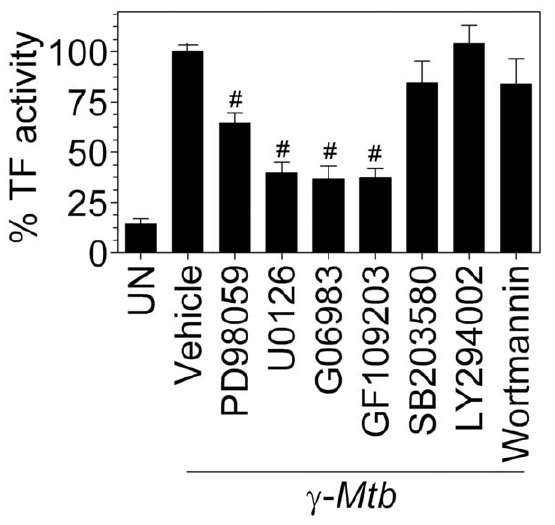
Figure 8. ERK and PKC pathways play a role in Mtb -induction of TF procoagulant activity. MDMs were pretreated with the MEK inhibitors, PD98059 and U0126 and PKC inhibitors, GF109203 and Go ¨ 6983, p38 MAPK inhibitor, SB203580 and PI3-AKT inhibitors, LY294002 and wortmannin (all used at 10 m M concentration) for 1 h. Cells were then stimulated with c - Mtb (10 m g/ml) for 9 h. Cell surface TF activity measured in factor X activation assay. Values obtained for c - Mtb alone treated cells are represented as 100%. # indicates significant inhibition compared to c - Mtb alone treated cells (P=0.0001). Data are mean 6 SEM ( n=7).